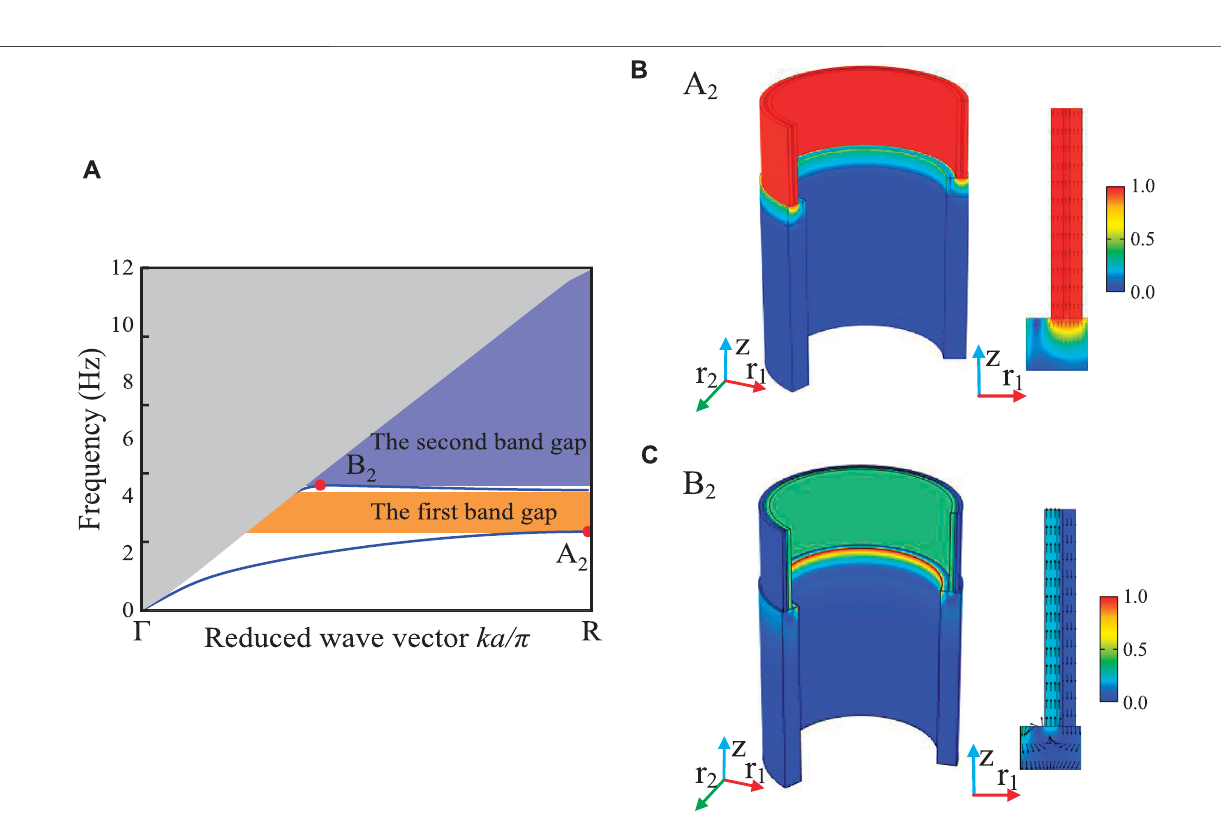
Frontiers in Materials |